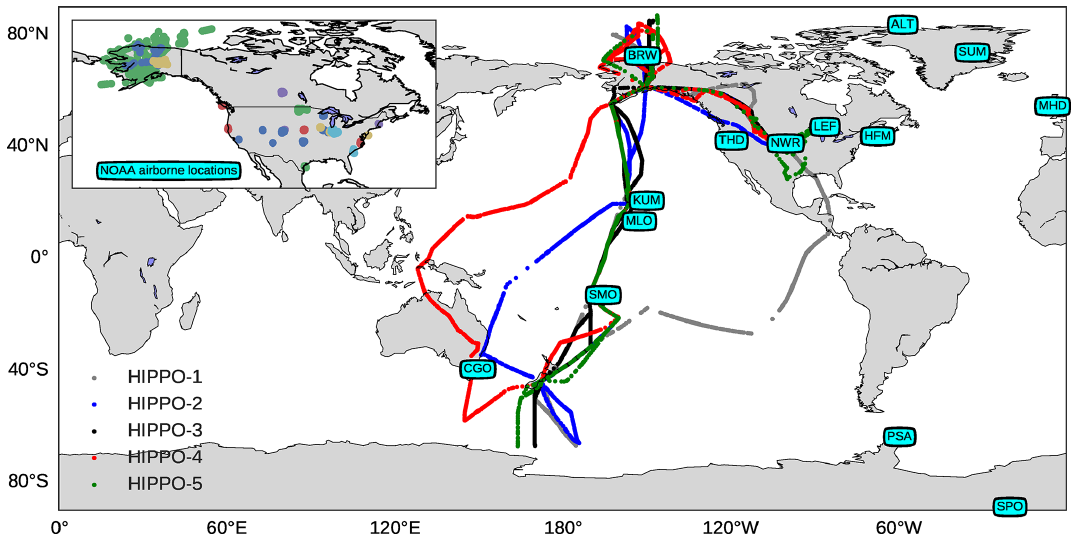
Figure 1. Geographical locations of the NOAA ground-based observations (shown in boxes), the five HIPPO campaign tracks and the NOAA profile programme (inset). Note that there are no NOAA surface stations located in Asia, South America or